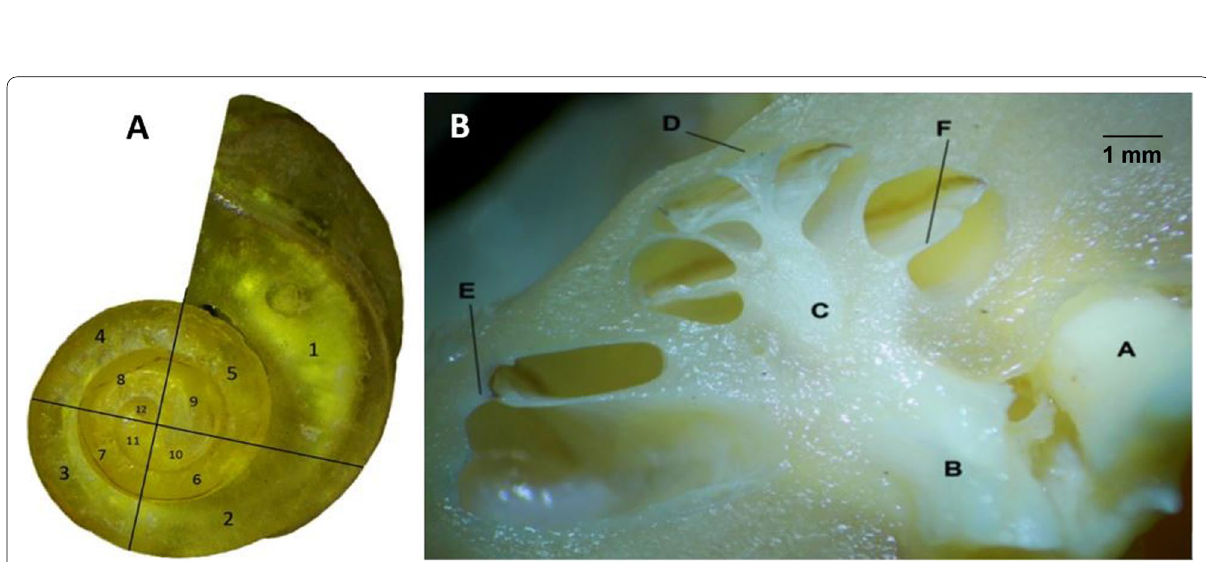
Fig. 2 A . Plastic cast of the camel labyrinth showing the spiral turns of the cochlea as viewed from the apex. The number of quarter-turns within the spiral might be counted by counting the number of times the spiral path intersected the two-plane containing the projection line and therefore the central axis of the spiral. B The cross-section in the camel cochlea after decalcification shows the height and width of the cochlea. A. Facial nerve, B. Cochlear nerve, C. Modiolus, D. Helicotrema, E. Spiral ligament, F. Secondary